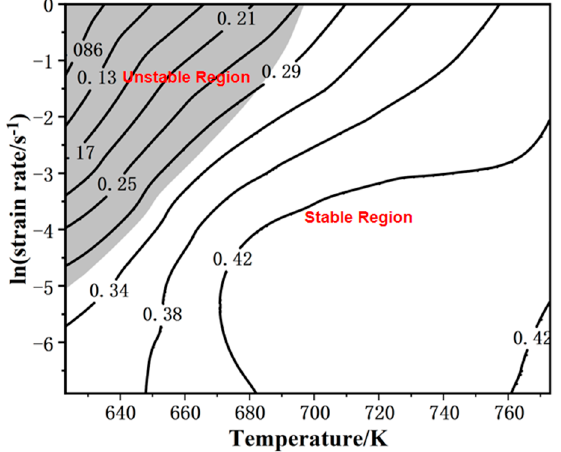
Figure 3. The hot processing map for Mg–Gd–Y–Zr–Ag alloy.